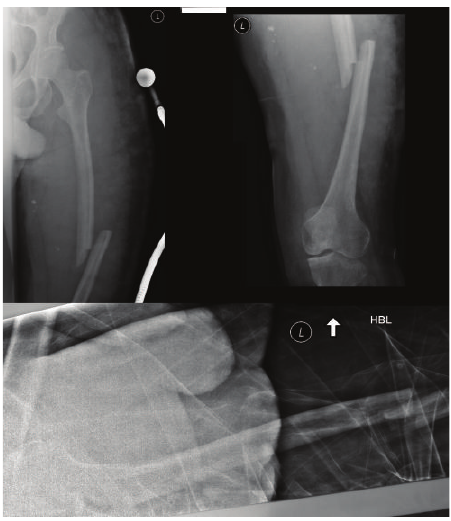
Figure 2: AP and lateral radiographs of the left femur, demonstrat- ing a complete diaphyseal